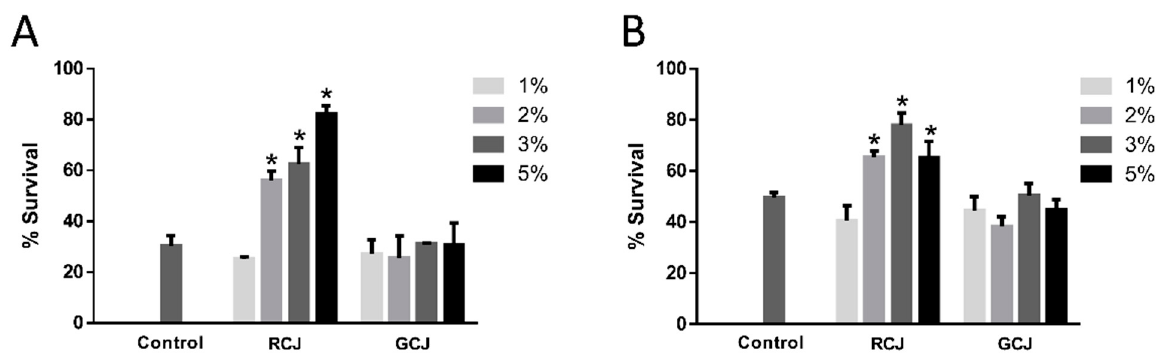
Figure 3. Effect of pretreatment with red cabbage juice (RCJ) and green cabbage juice (GCJ) on resistance to stress in C. elegans . Synchronized L1 larvae worms were treated with RCJ and GCJ for 3 days and exposed to stressors: ( A ) 10 mM paraquat for 3.5 days ( n > 60); ( B ) 35 °C heat shock for 4 h ( n > 60). Data are presented as mean ± SD. * p < 0.05 vs. control by one-way ANOVA followed by Bonferroni correction.